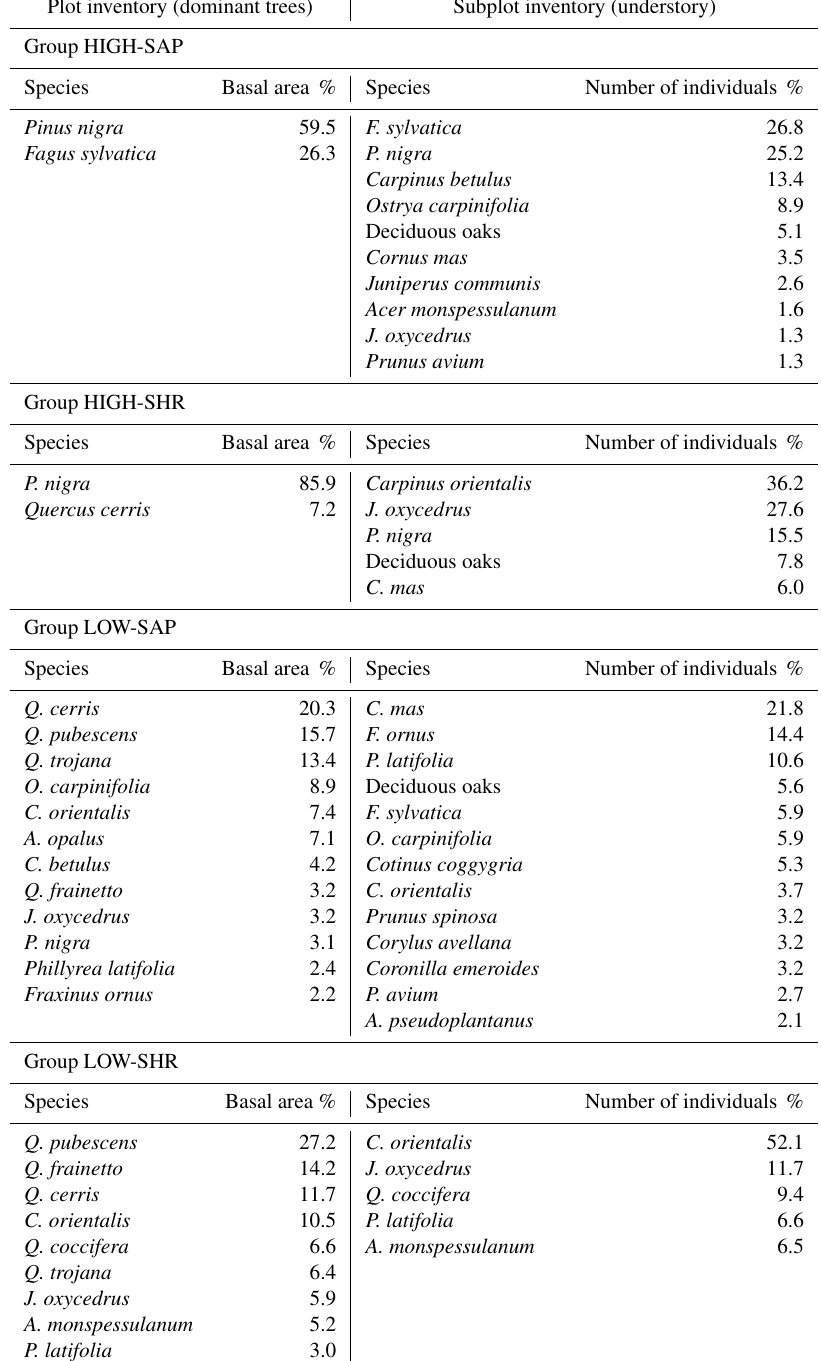
Table J1. Species composition and abundance for the four main woody plant groups of dominant canopy trees and understory saplings and shrubs defined in Table 2. Only species contributing to a cumulative 90% of the cluster composition are